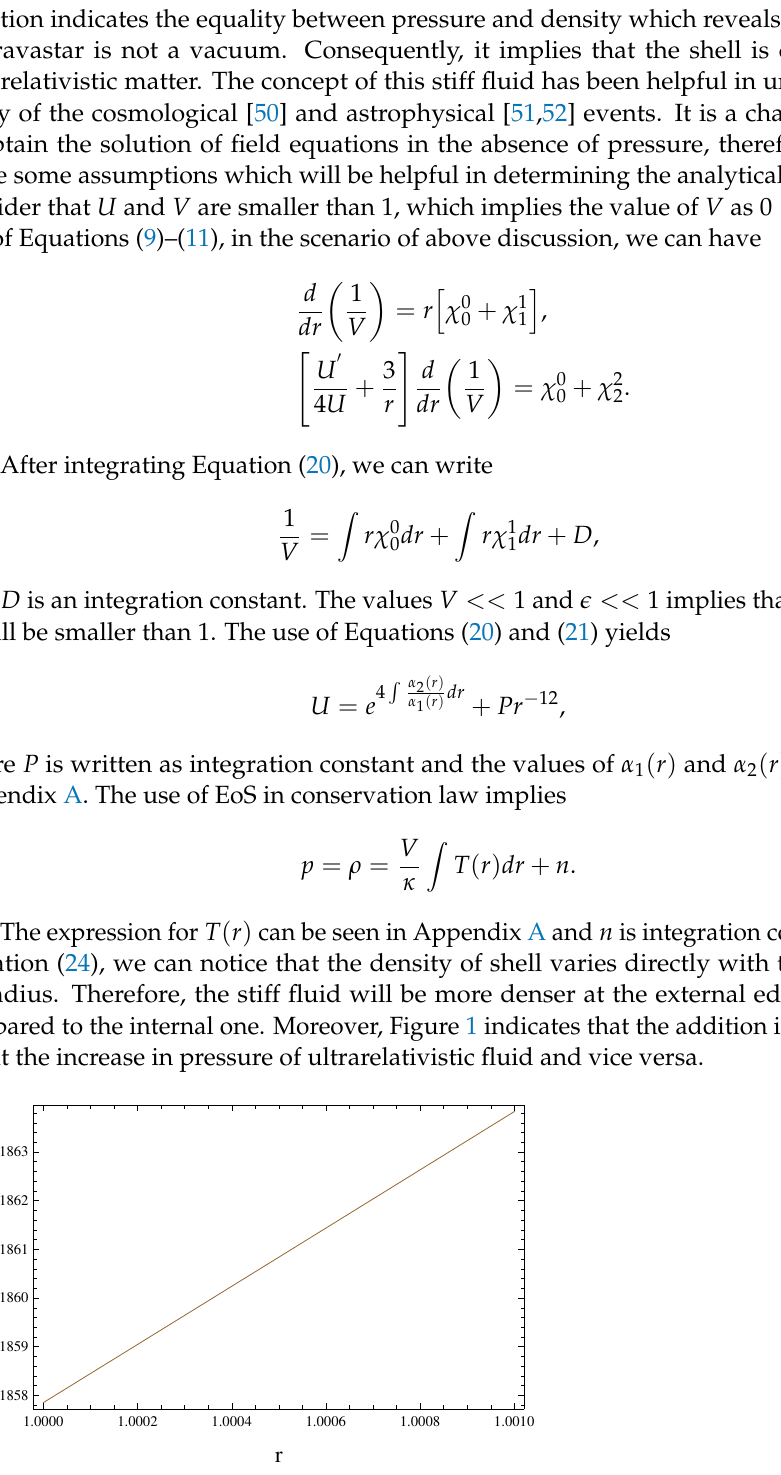
Figure 1. Graphical demonstration of density (km − 2 ) correspondence with r